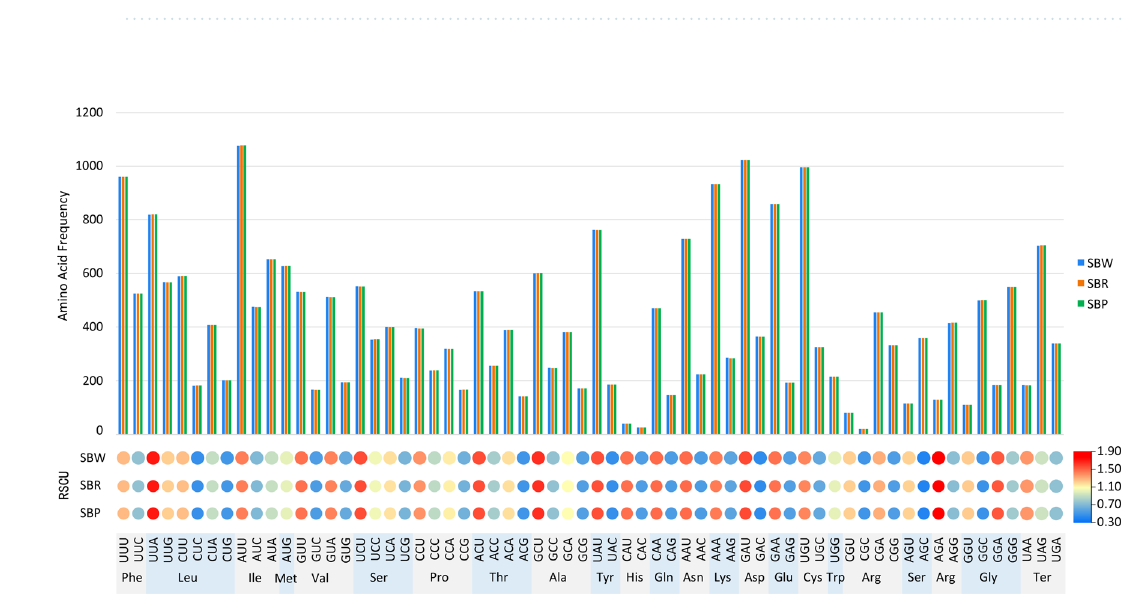
Figure 3. The RSCU values of all protein-coding genes for three cultivated varieties. Color key: the red values indicate higher RSCU values, and the blue values indicate lower RSCU